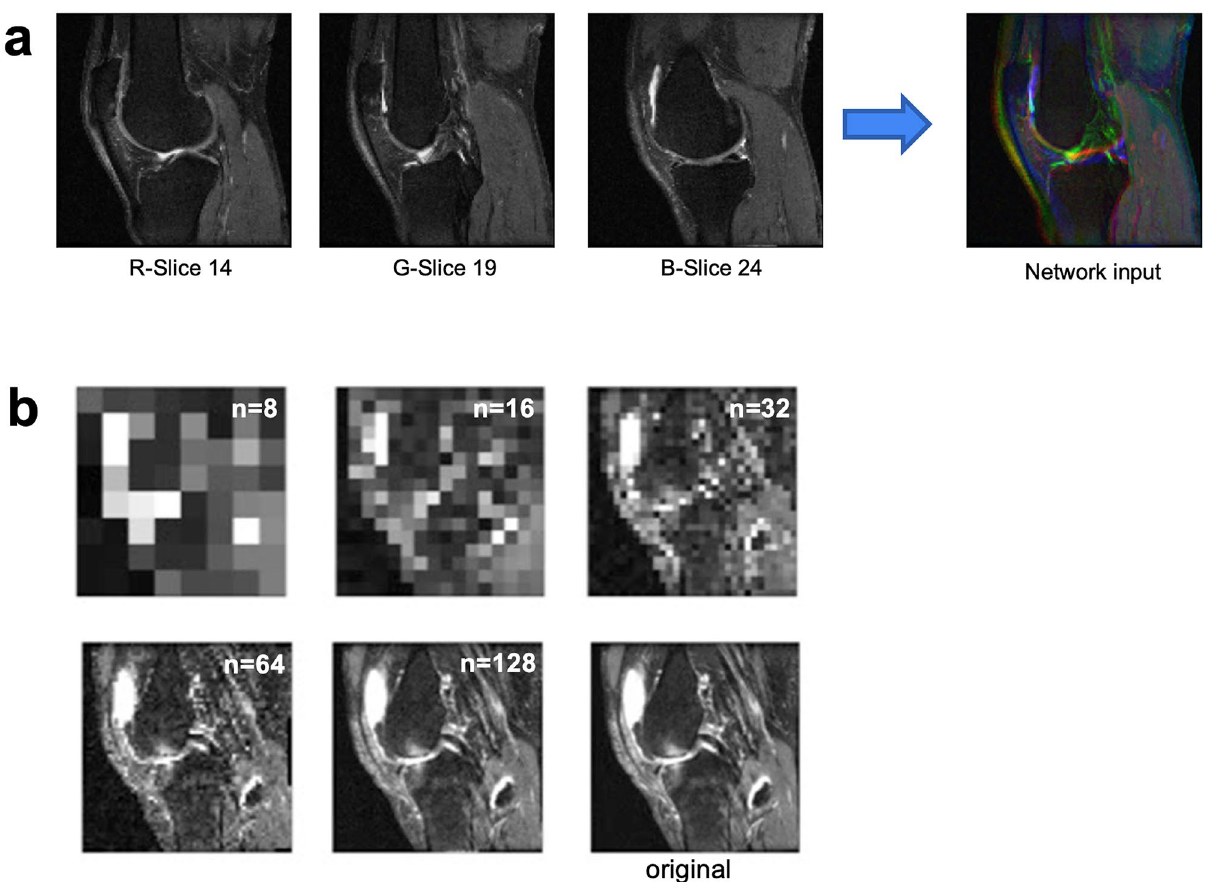
Figure 2. ( a ) Data creation through image slice combinations. Input images are created by treating intermediate slices as red, green, and blue color channels, and stacking them. Augmented images are created by stacking adjacent intermediate slices. ( b ) Example of image energy retained with progressively higher resolution.